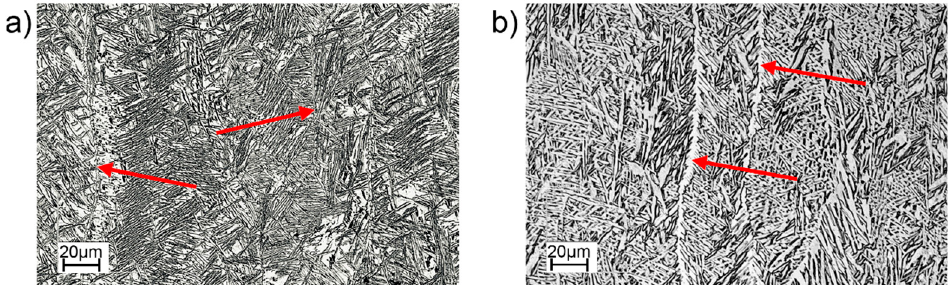
Figure 6. Microstructure of PBF-EB/Ti-55511: ( a ) as-built, ( b ) HIP. Borders of the column ( α GB) marked by red arrows. Optical microscope.